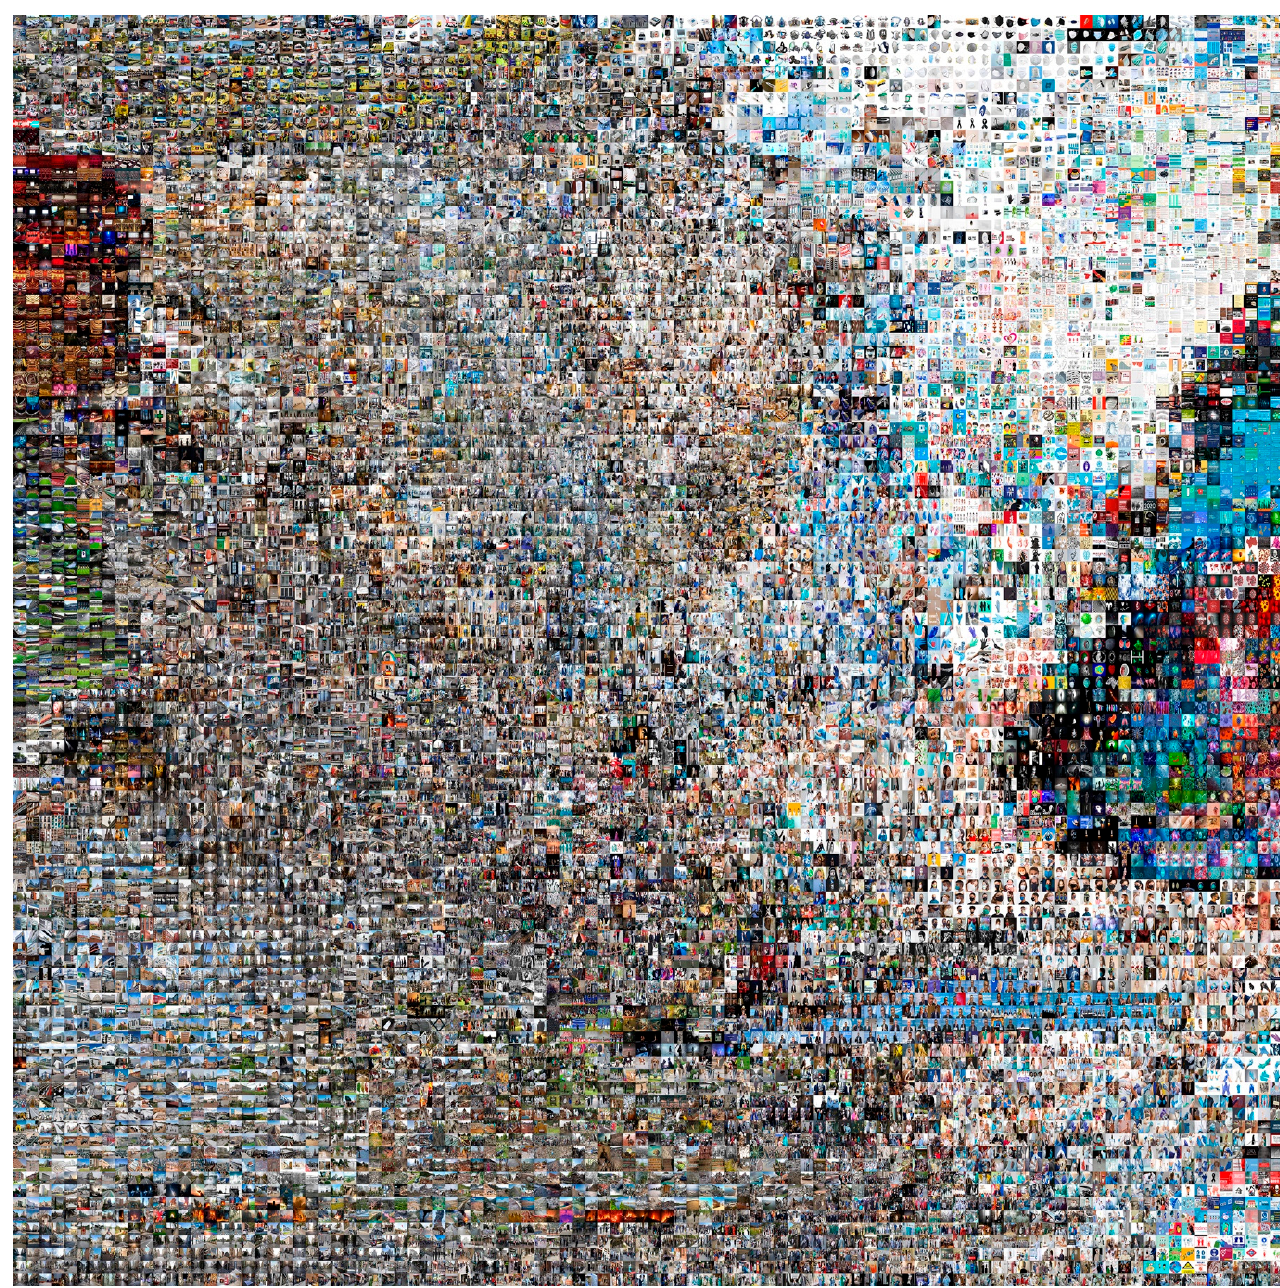
Figure 14. Digital image containing 10,000 images regarding the COVID-19 pandemic (2 × 2 m). © Pilar Rosado.